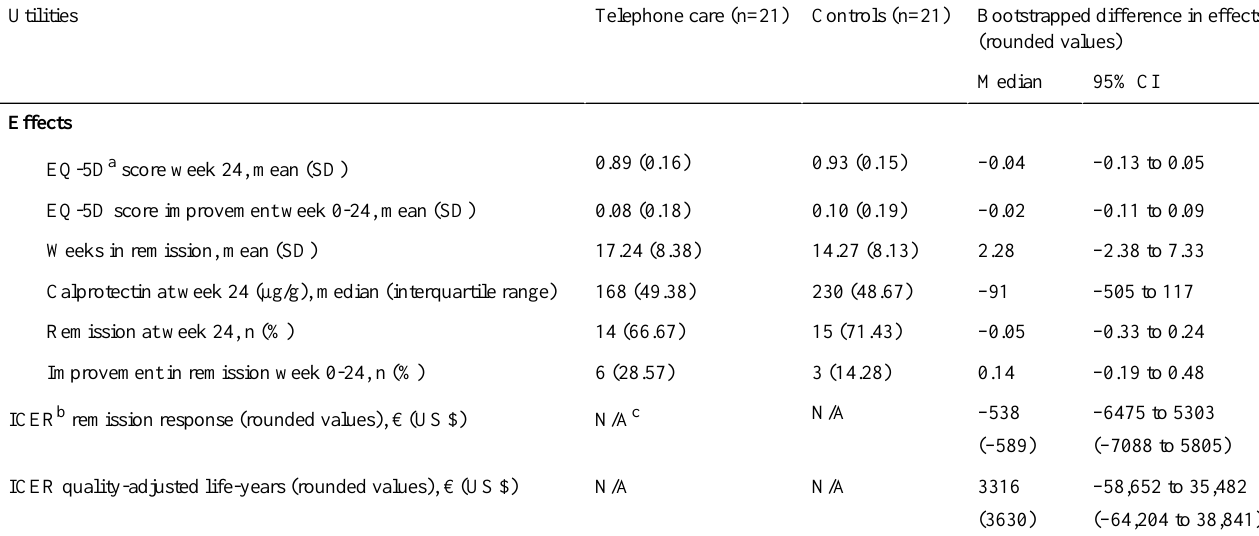
Table 8. Utilities per patient in the group receiving nurse-assisted telephone care (G_NT) vs standard care